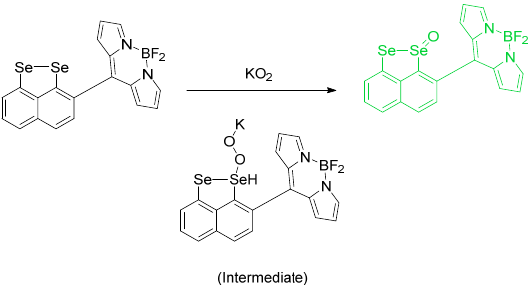
Figure 13. The recent novel diselenide probe reported by Madibone et al.